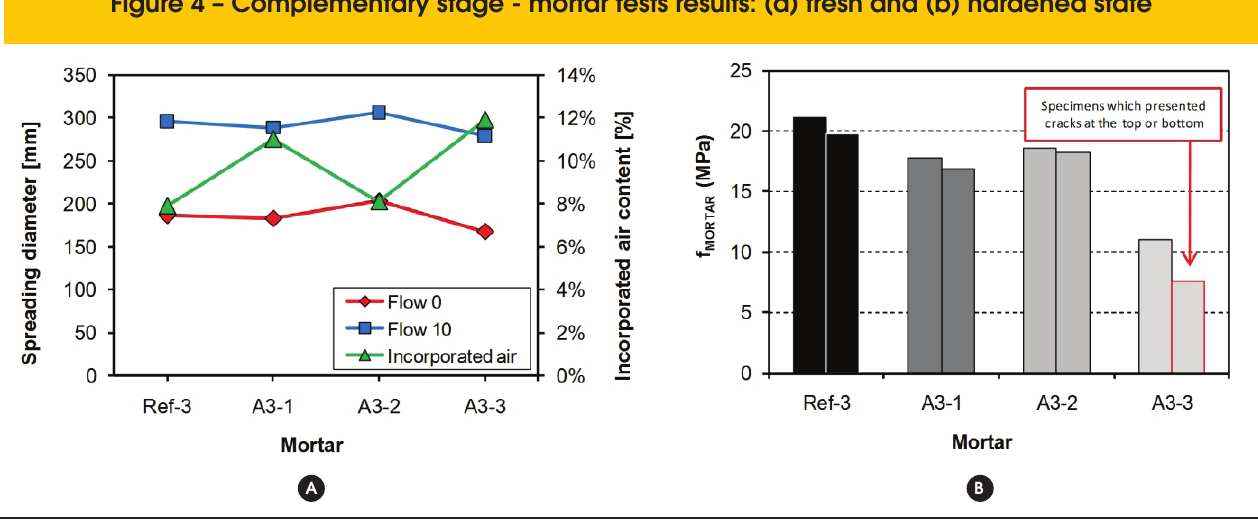
Figure 4 – Complementary stage - mortar tests results: (a) fresh and (b) hardened